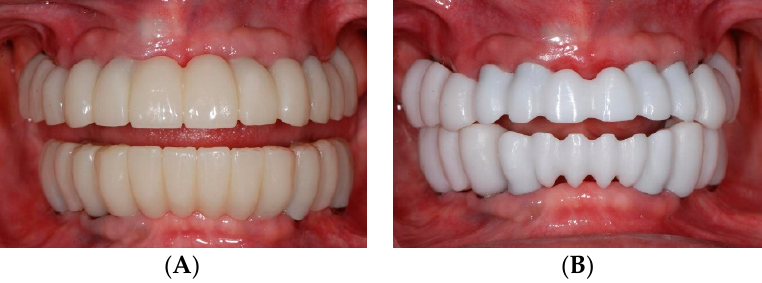
Figure 7. Verification of prototypes and milling of zirconia after re-scanning. ( A ) PMMA prototype. ( B ) Anterior milled zirconia framework and posterior monolithic zirconia.